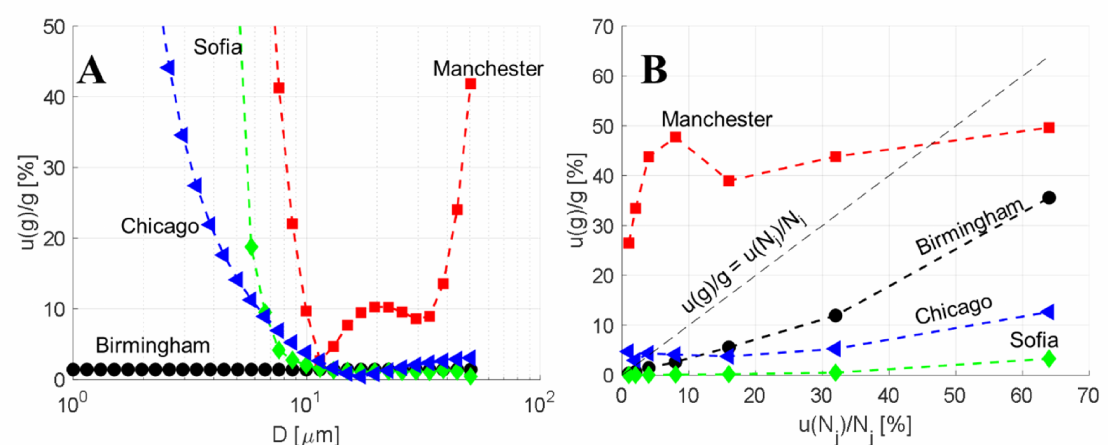
Figure 3. ( A ) Relative uncertainty for each size class (comparing the four methods), when supplied with a low relative uncertainty in the drop size classes (4%). ( B ) Relative uncertainty in the size class corresponding to D = 30 µ m, as a function of the relative uncertainty of the